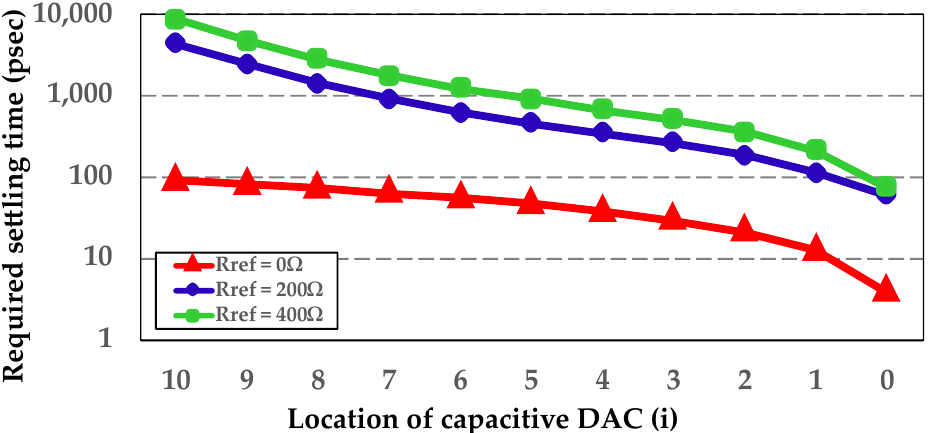
Figure 3. A comparison between considering reference buffer or not.